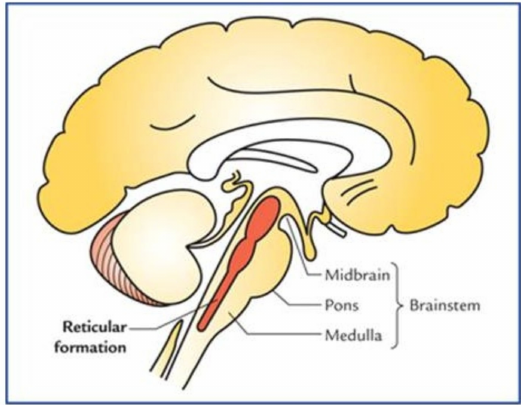
Figure 2. The Reticular Formation [57] (fair